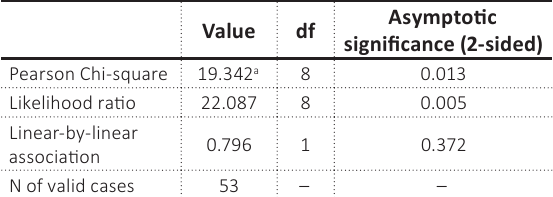
Table 3. Chi-square tests between general